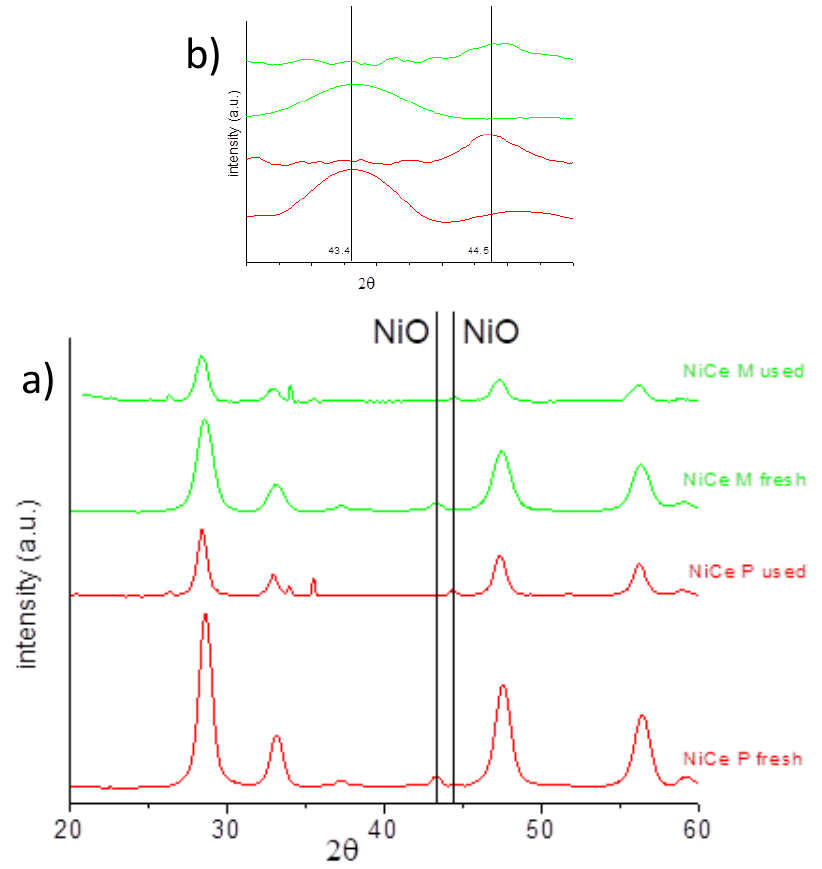
Figure 8. ( a ) XRD patterns of fresh and used catalysts after calcination. (Reflections at 2 θ 35° are due to remains of SiC used as diluent in the catalytic bed.) and ( b ) magnification on reflections of NiO at 2 θ 43.3 and 44.5°.